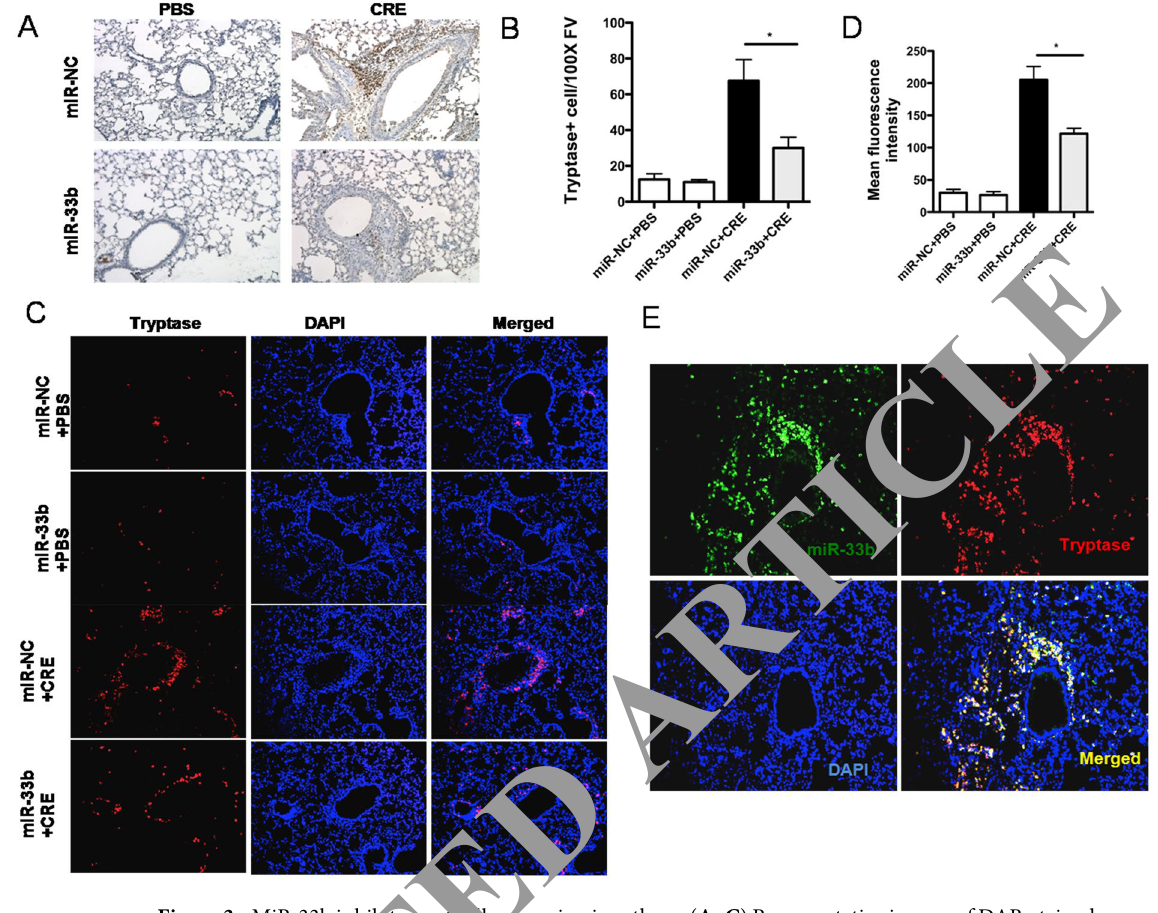
Figure 3. MiR-33b inhibits mast cell expression in asthma. ( A – C ) Representative images of DAB-stained tryptase and immunofluorescence in lung tissue sections of PBS- (n = 3) or CRE-challenged C57BL/6 mice that were transfected with miR-NC and miR-33b. ( B – D ) Quantitative data of DAB staining and immunofluorescence. ( E ) Representative images of co-immunofluorescence staining with tryptase and GFP-miR-33b in the lung tissues of CRE-challenged WT mice. The quantitative data are representative of 3 independent experiments. The data are means ± SEM. * P <